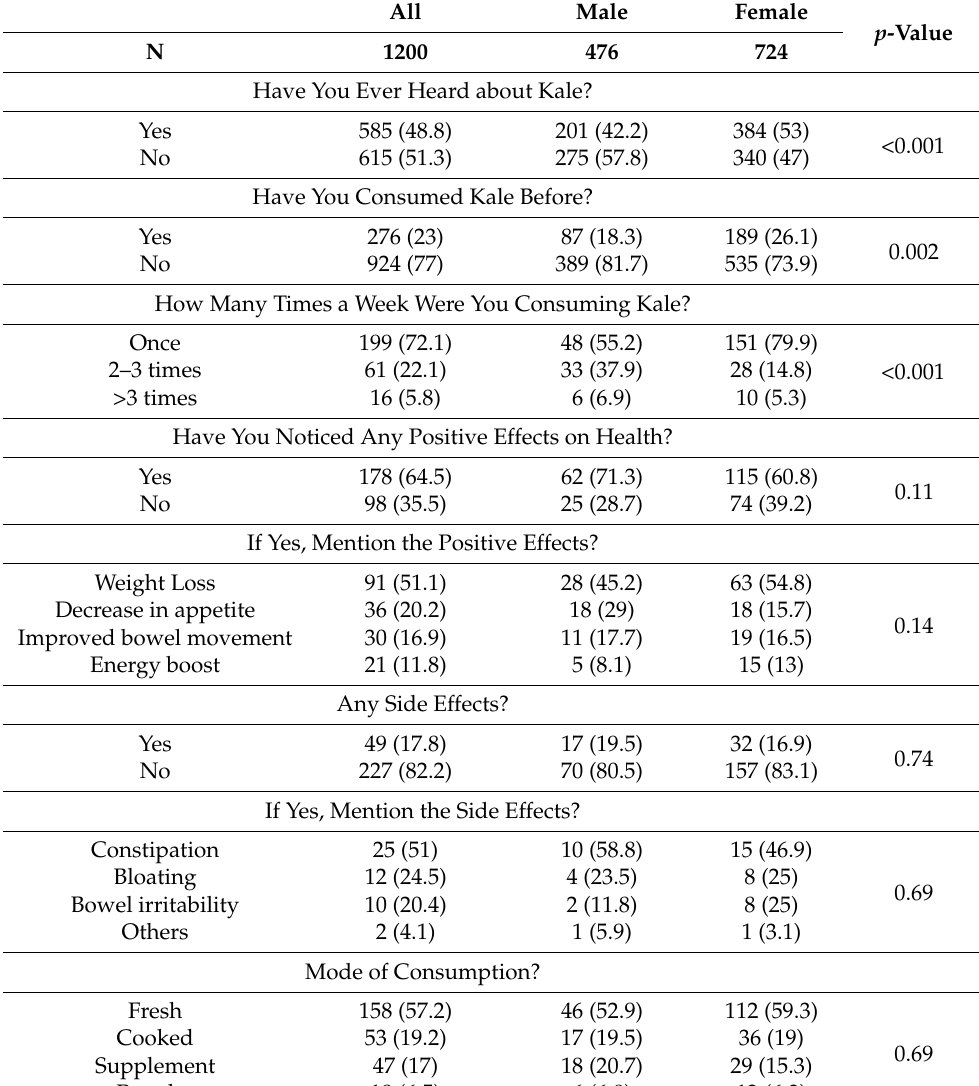
Table 4. Kale consumption and its health effects in the study